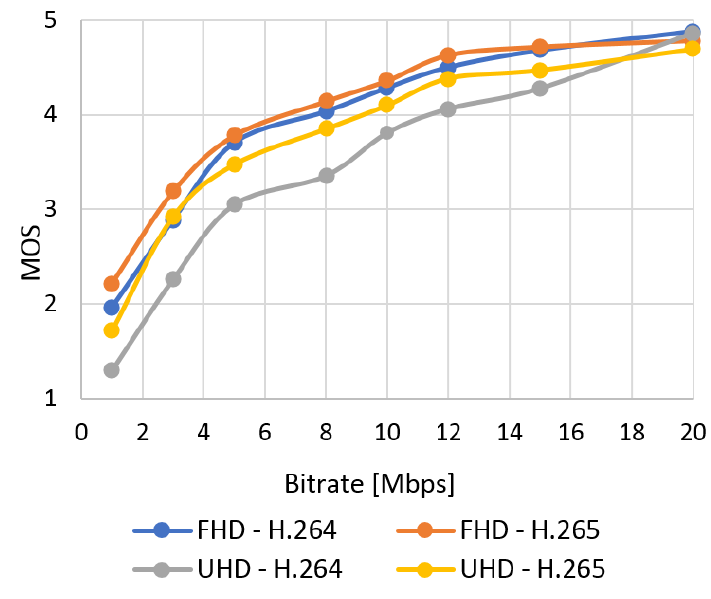
Figure 16. The average results of MOS.